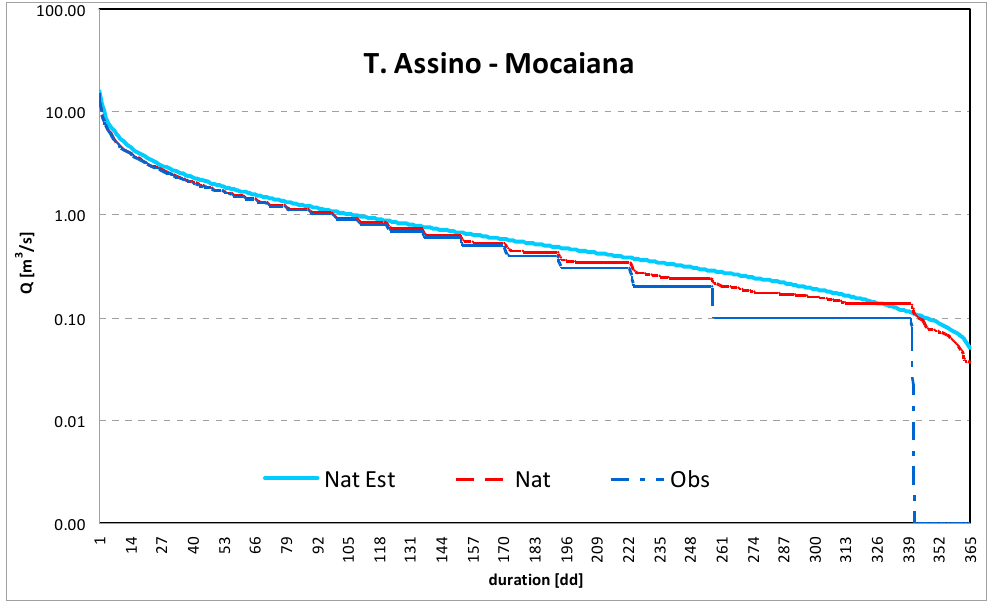
Figure 4. Flow duration curves (FDCs) in the Mocaiana basin. Estimated natural FDC (Nat Est), natural FDC (Nat), and observed FDC (Obs).